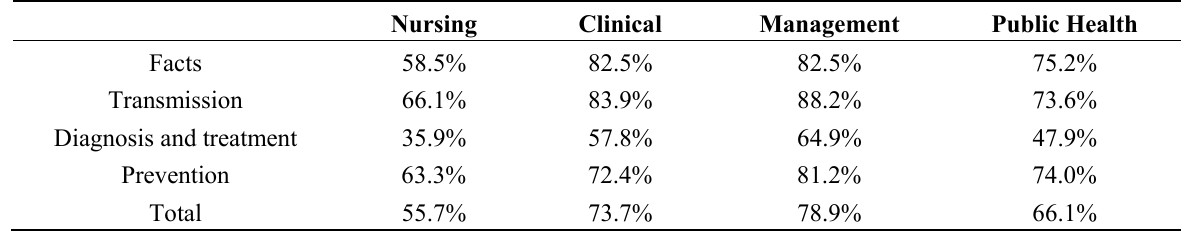
Table 2. The rate of correctly answered questions in each category by major (%